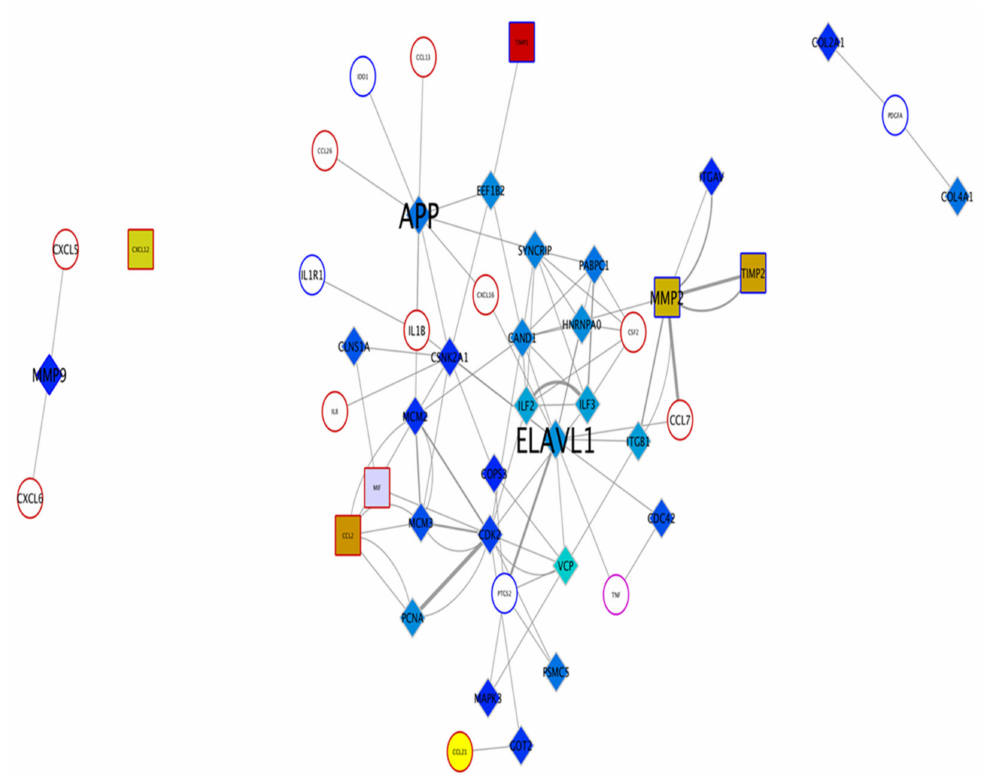
Figure 2. Protein–protein interaction network showing the interactions for the measured cytokines to the proteomics data obtained by the LC-MS identification of iPSC-CM proteins. Diamonds represent proteins detected uniquely in the iPSC-CM; squares represent proteins detected in both the control medium and the iPSC-CM; circles represent proteins that are measured by multiplex after treatment but were not detected in either medium. The node border color indicates the dataset; blue indicates a gene or protein present in the PCR dataset (supplementary data, Table S1 and S2); red indicates proteins that are part of the cytokine panel, and purple indicates proteins present in both datasets; grey indicates proteins that were part of neither panel. The font size indicates the degree of a node in the